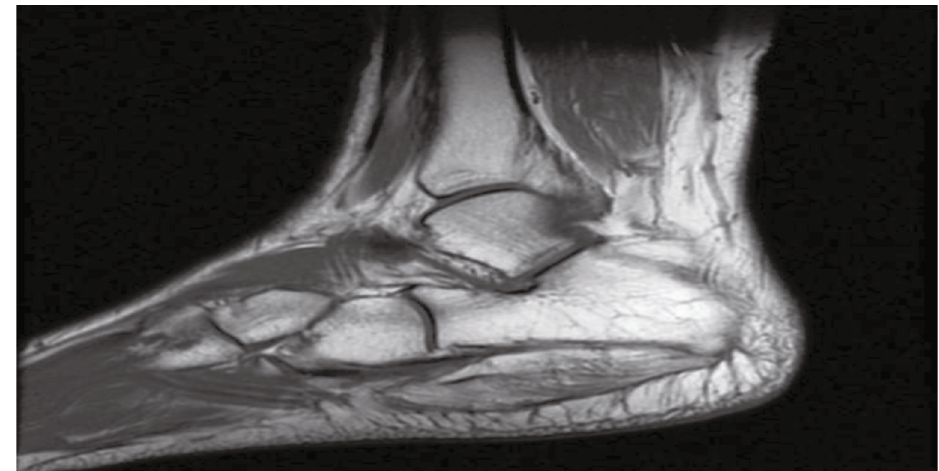
Figure 2: Magnetic resonance image of the right foot, Sag T1 showing di ff use enlargement of the muscle, with increased signal intensity. The muscle fi bers are